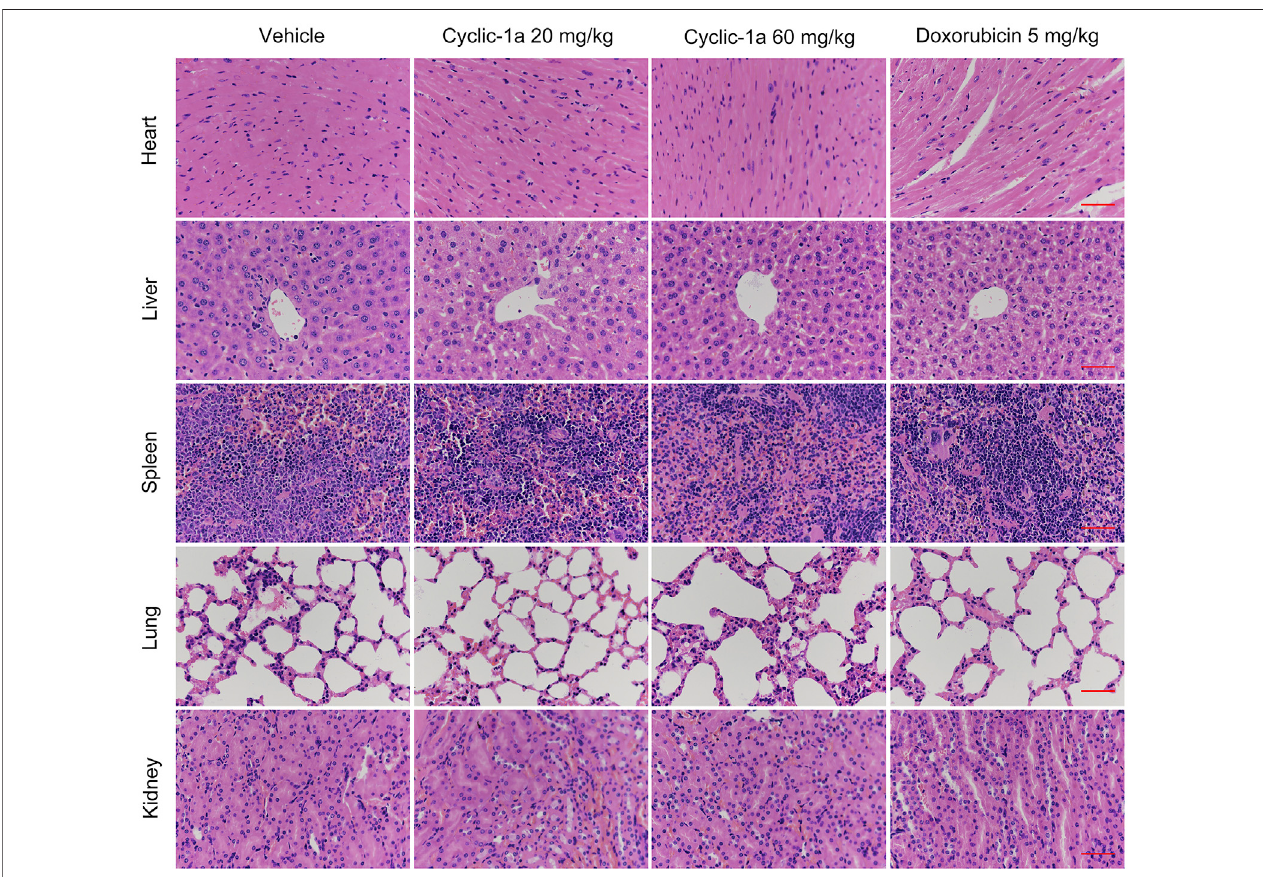
FIGURE 6 | Morphological changes of organs in tumor-bearing mice (Scale bar (cid:1) 50 μ m).